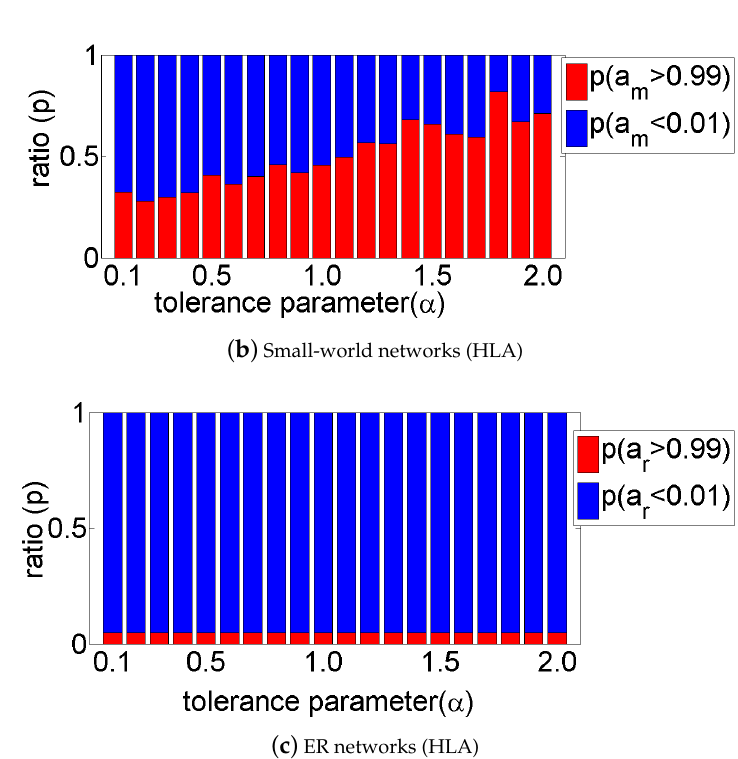
Figure 2. Probabilities of the extents of cascading failures for three network types under highest loads attacks.